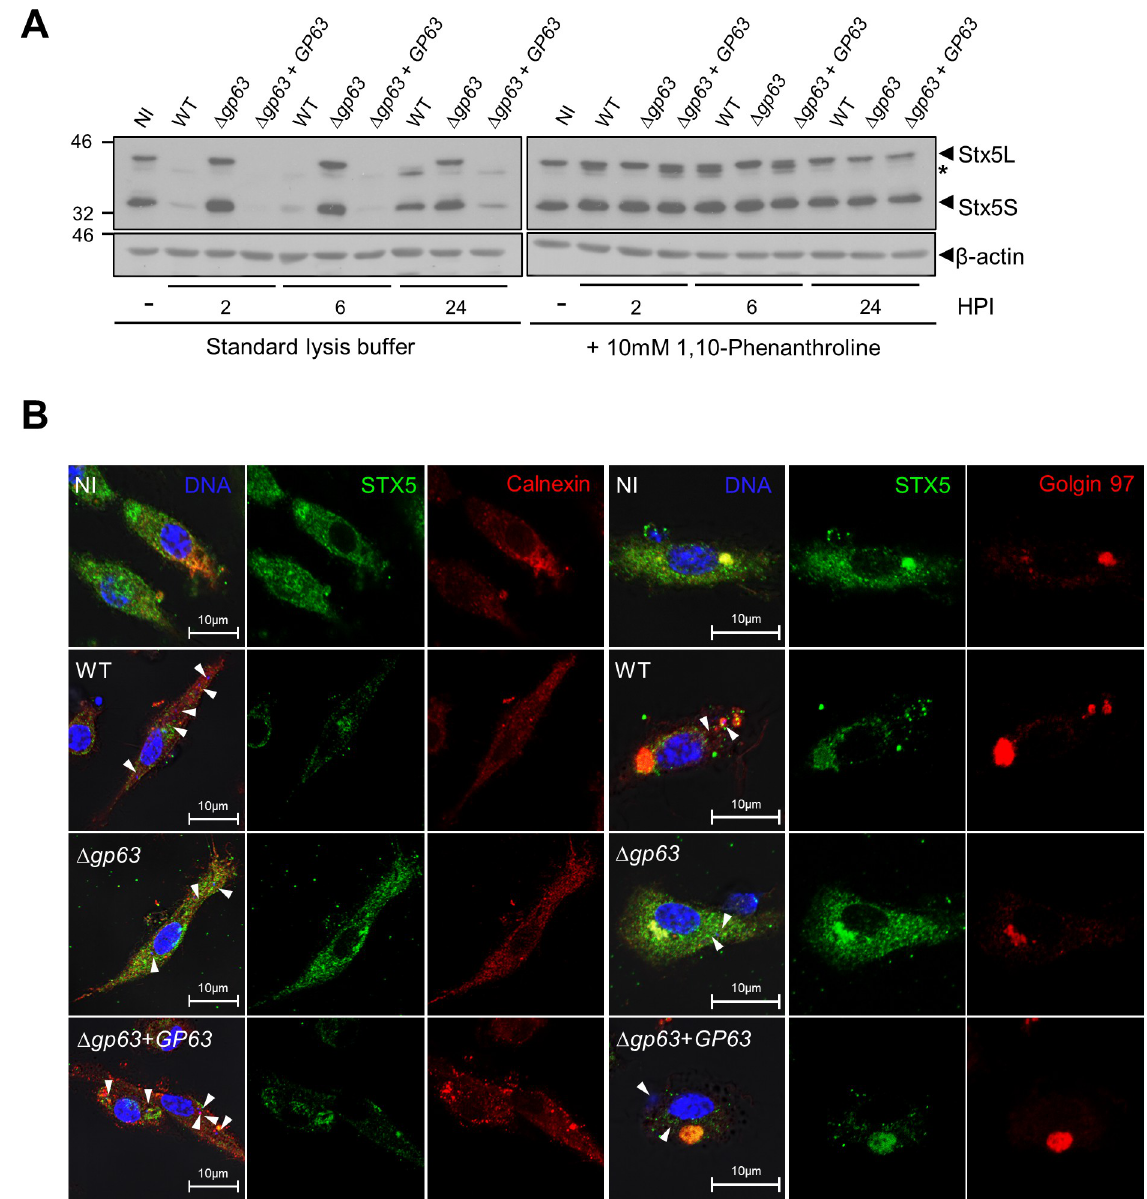
Fig 5. Stx5L is a genuine GP63 target. A. Lysates of uninfected BMM (0 h post-infection) or BMM infected with either WT, Δ gp63 , or Δ gp63 + GP63 L . major metacyclic promastigotes were prepared at the indicated time points in standard lysis buffer or in lysis buffer containing 10 mM 1,10-phenanthroline. Levels and integrity of Stx5L and Stx5S were assessed by Western blot analysis. β -actin was used a loading control. Asterisk denotes cleavage fragments. Immunoblots shown are representative of at least four independent experiments. NI, non-infected BMM; HPI, hours post-infection. B. BMM were infected with either WT, Δ gp63 , or Δ gp63 + GP63 L . major metacyclic promastigotes for 6 h and the distribution of Stx5 (green) with respect to the distribution of Calnexin (red) or Golgin 97 (red) was examined by immunofluorescence confocal microscopy. White arrowheads denote internalized parasites. These results are representative of three independent experiments. DNA is in blue; bar, 10 μ M.